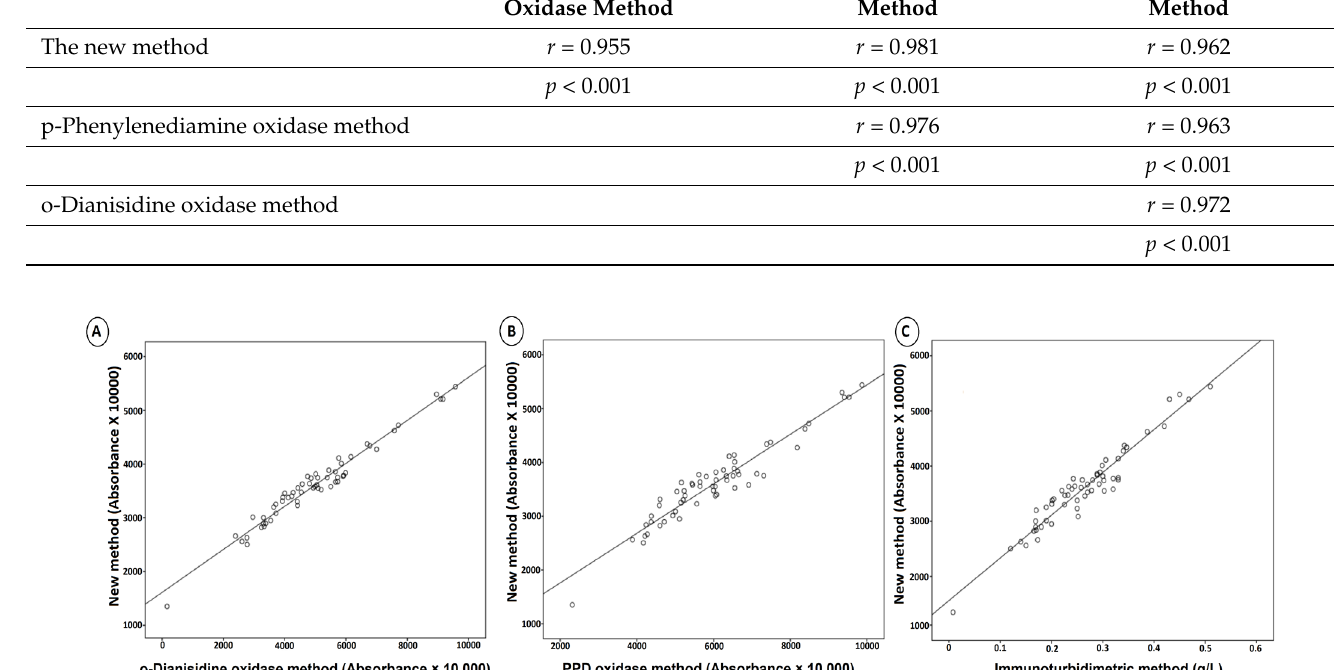
Table 3. The relationship between the conventional CP oxidase measurement methods and the newly developed ferroxidase method ( n = 59). Figure 3. The absorbance spectrum of the substrate (Fe +2 ) and the product (Fe +3 ) formed by the fer- roxidase enzyme.